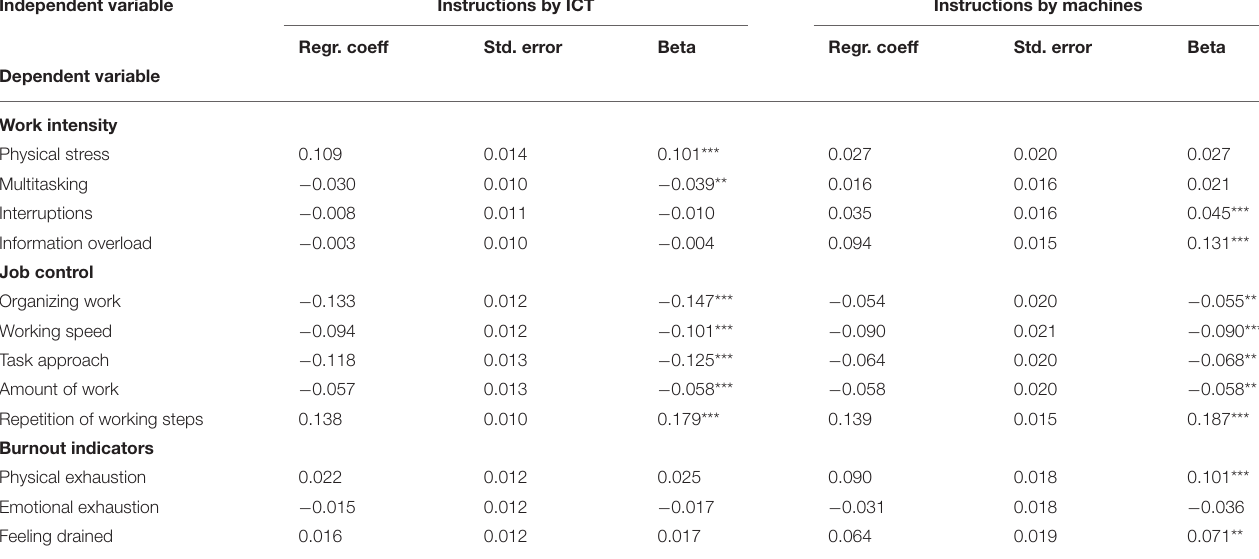
TABLE 3 | Linear regressions. Independent variable Instructions by ICT Instructions by